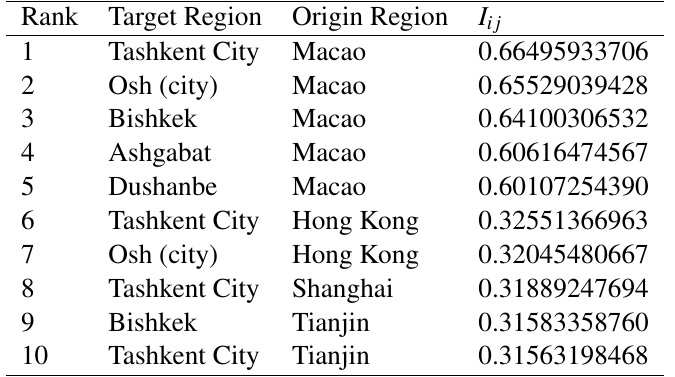
Table 3 . Table 3 Top ten regions of I ij between China and five Central Asian